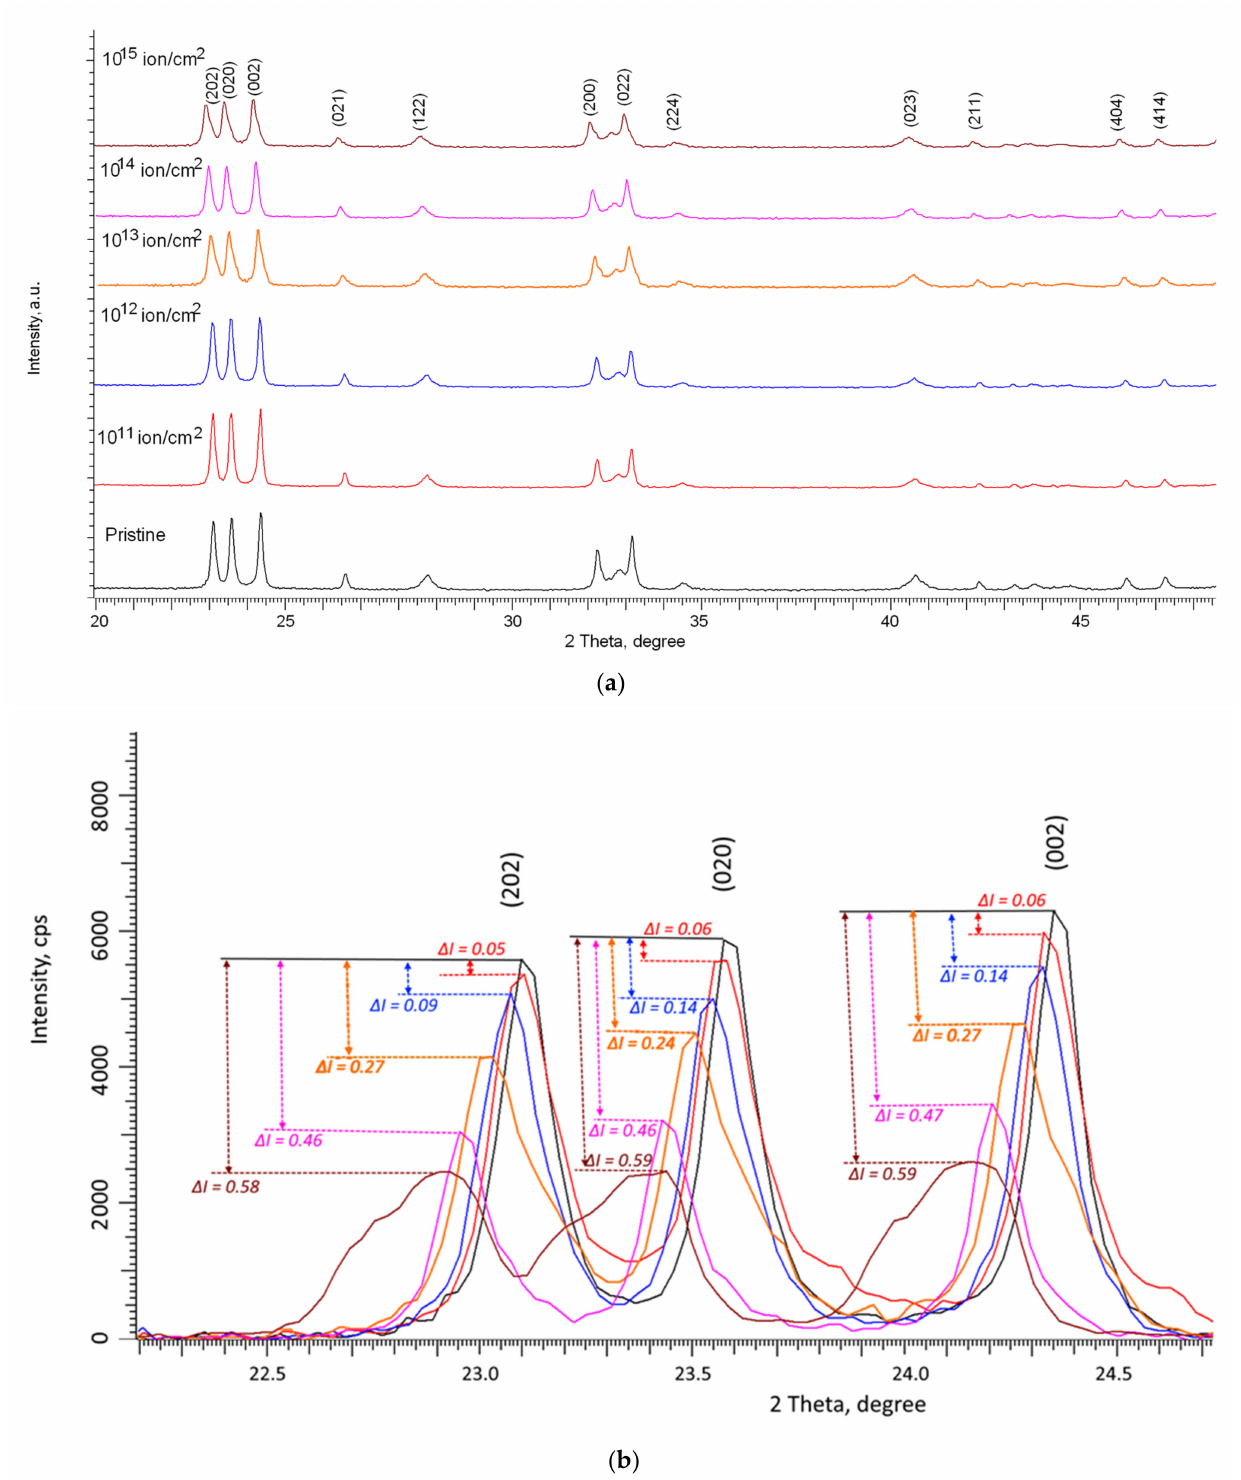
Figure 3. ( a ) Results of X-ray diffraction of the studied samples of WO 3 microparticles depending on the fluence of irradiation with Xe 22+ ions; ( b ) Detailed representation of the change in the intensity of the main diffraction reflections depending on the irradiation fluence. At the same time, according to the presented X-ray diffraction patterns, no new peaks are observed for the irradiated samples, which indicates the absence of initiation of polymorphic transformation processes as well as the formation of impurity